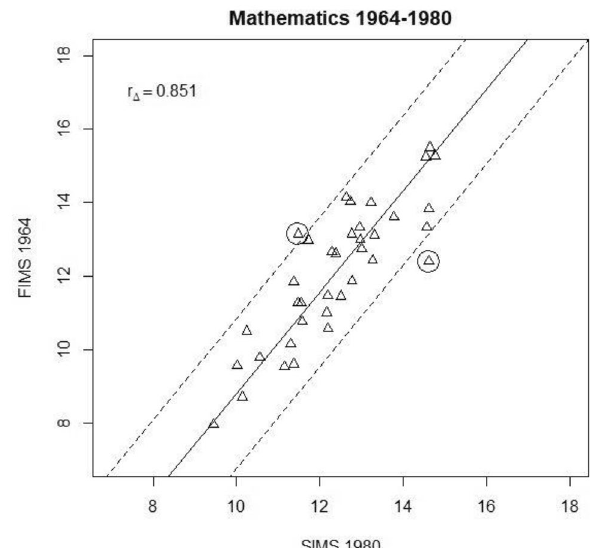
Fig. 4 Delta plot of the bridge between FIMS and SIMS